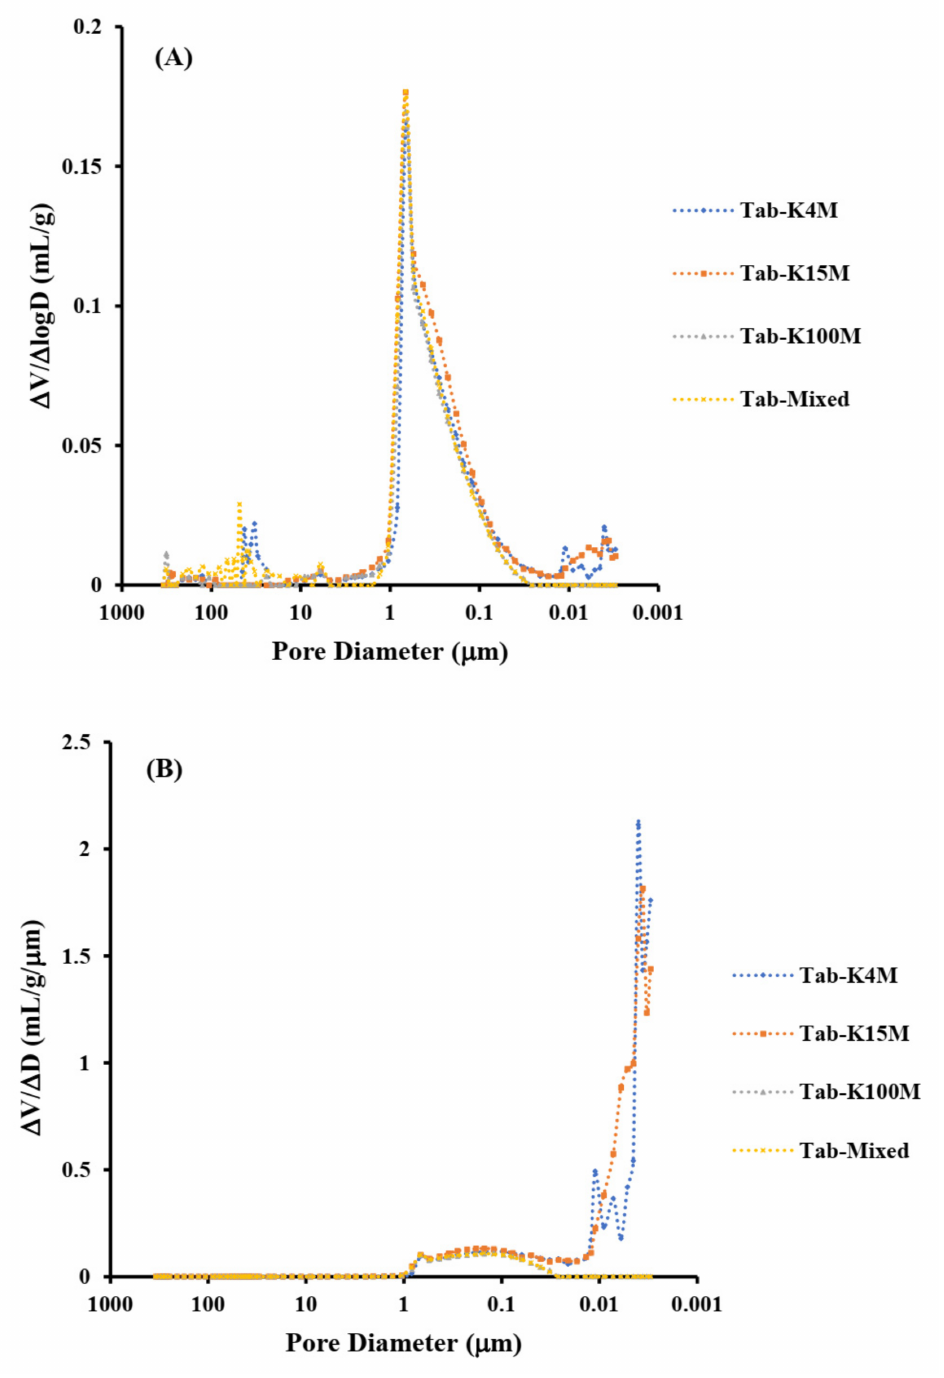
Figure 6. Logarithmic volume size distribution ( ∆ V/ ∆ logD) of compressed HPMC-based ma- trix tablets ( A ) and pore volume size distribution ( ∆ V/ ∆ D) of compressed HPMC-based matrix tablets ( B